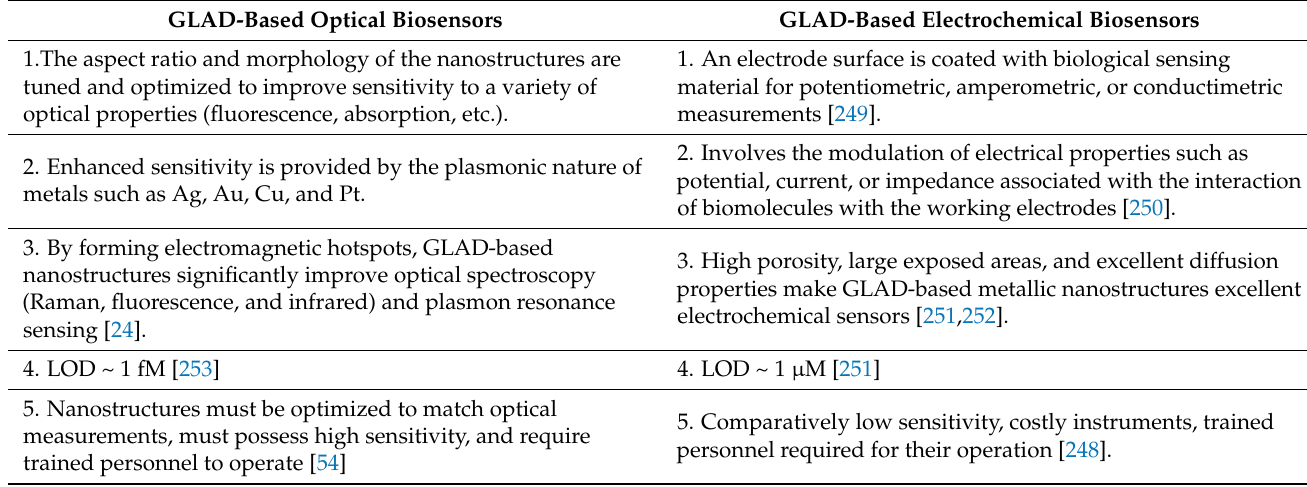
Table 1. Comparative study of GLAD-based optical biosensors and electrochemical